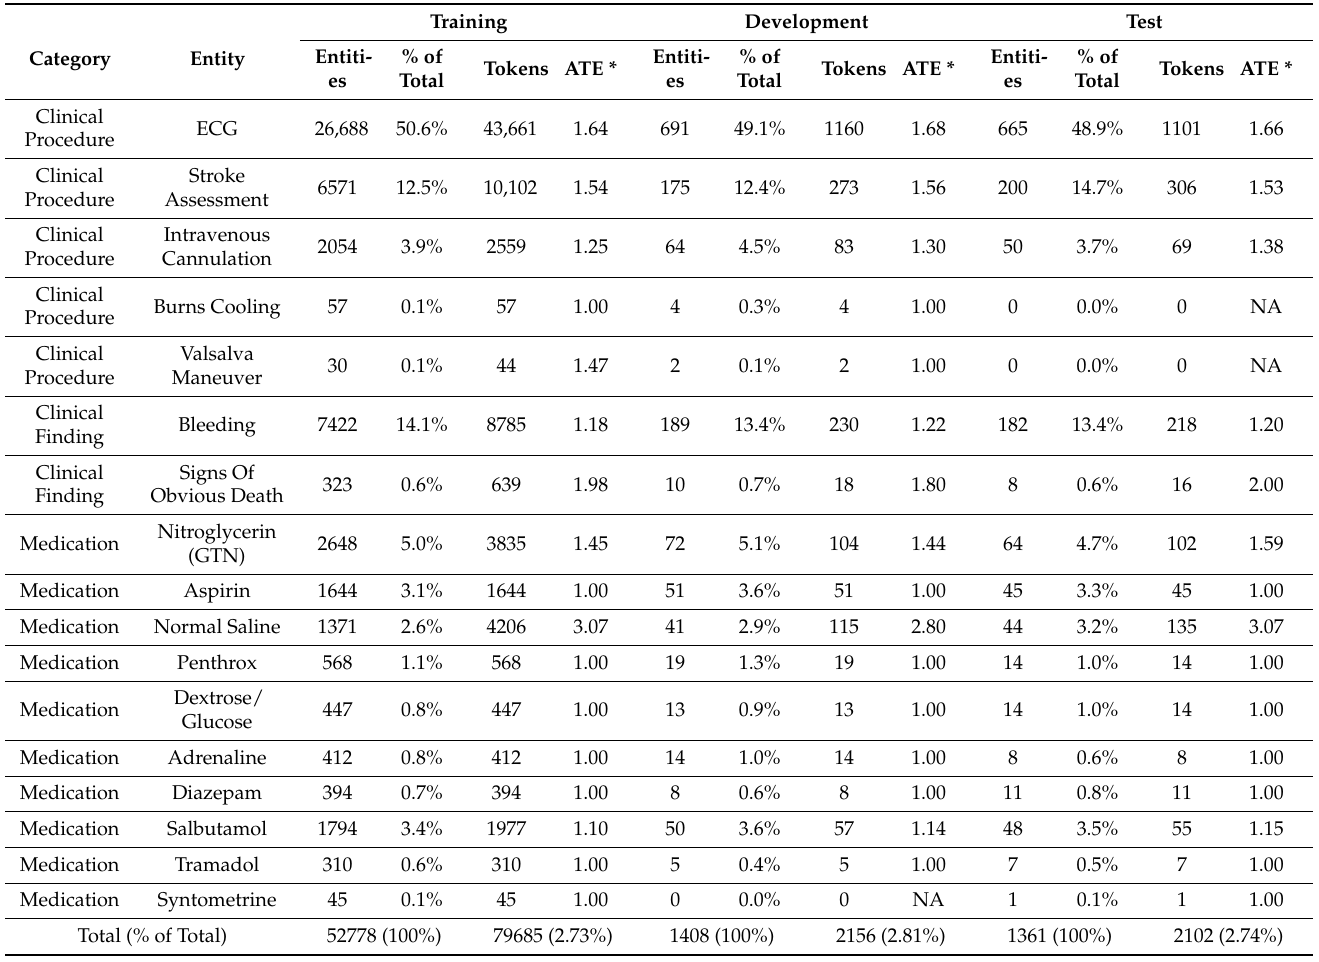
Table 2. Overview of the named clinical entities in our dataset. Around 2.7% of the tokens are associated with an entity, and the rest are “O” tokens.